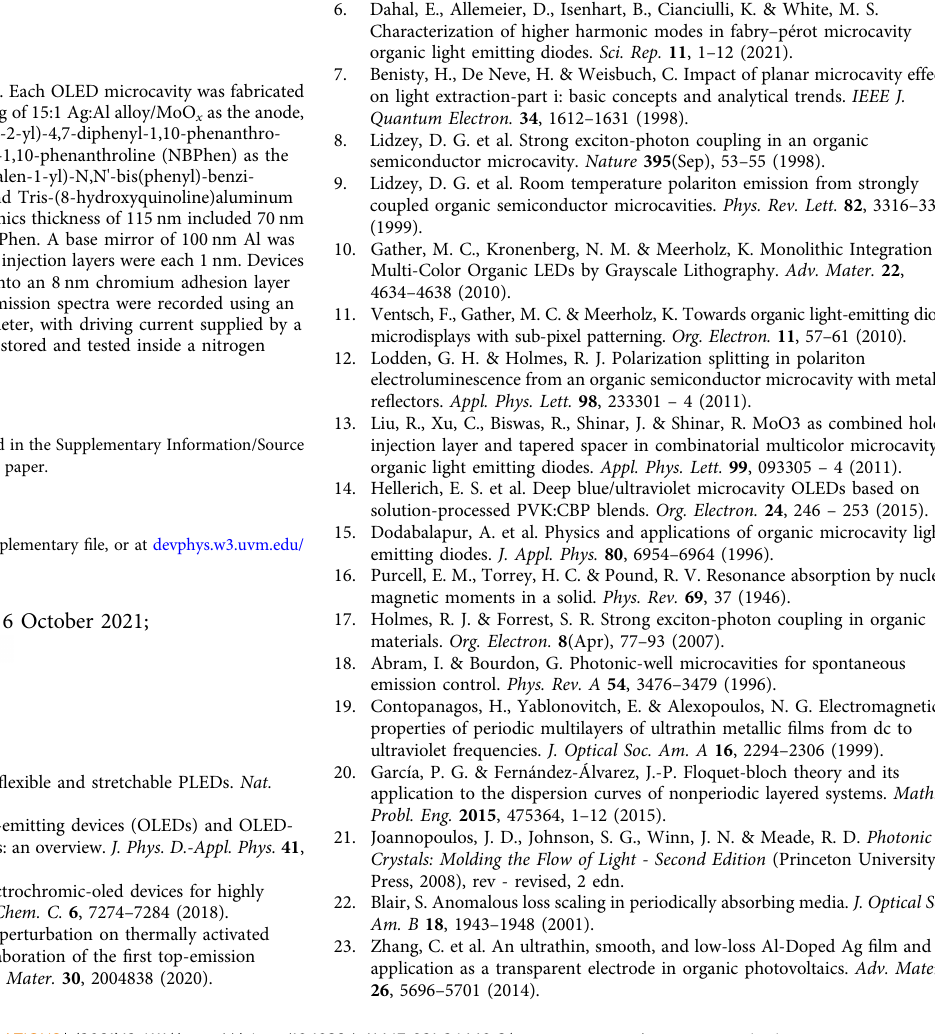
speci fi c emission patterns — including the entire white spectrum range.